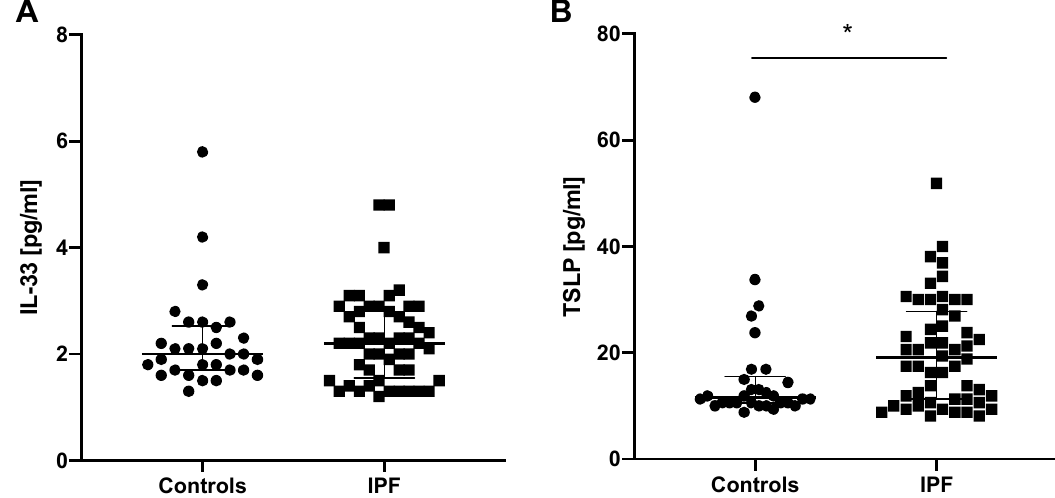
Figure 1. Baseline epithelial alarmin levels in the serum of controls and patients with IPF. Notes: Panels showing: ( A ) baseline IL-33 serum levels; ( B ) baseline TSLP serum levels; * p < 0.05. IL-25—interleukin 25, IL-33—interleukin 33, TSLP—thymic stromal lymphopoietin, IPF—idiopathic pulmonary fibrosis.